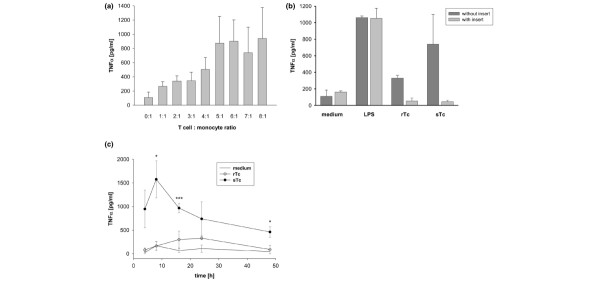
T cell induced production of TNF-α by monocytes from healthy donors. (a) Fixed stimulated T cells induce tumour necrosis factor (TNF)-α production by monocytes in a dose-dependent manner. Peripheral-blood T cells (106/ml) were cultured for 48 hours in the presence of immobilized anti-CD3 (3.3 μg/ml) and soluble anti-CD28 (0.8 μg/ml) antibodies. Stimulated T cells were fixed and incubated for 24 hours with freshly isolated monocytes (1.5 × 106/ml) at the indicated ratios. Values are means ± SEM from four different experiments. (b) Cell–cell contact is necessary for T cell-induced production of TNF-α in monocytes. Peripheral-blood T cells (106/ml) were cultured for 48 hours in the presence or absence of immobilized anti-CD3 (3.3 μg/ml) and soluble anti-CD28 (0.8 μg/ml) antibodies. Stimulated (sTc) and resting (rTc) T cells were fixed and incubated for 24 hours with freshly isolated monocytes (1.5 × 106/ml) at a ratio of 7:1 in a transwell system as described in the Materials and methods section. T cells and monocytes were physically separated by the semi-permeable membrane (with insert) or had direct cell–cell contact (without insert). Lipopolysaccharide (LPS; 100 ng/ml) was used as a positive control. Values are means ± SEM for experiments with three different donors. (c) T cell-induced TNF-α production by monocytes is time-dependent. Peripheral-blood T cells (106/ml) were cultured for 48 hours in the presence or absence of immobilized anti-CD3 (3.3 μg/ml) and soluble anti-CD28 (0.8 μg/ml) antibodies. Stimulated (sTc) and resting (rTc) T cells were fixed and incubated for the indicated durations with freshly isolated monocytes (1.5 × 106/ml) at a ratio of 7:1. Values are means ± SEM for experiments with three different donors. Levels of significance: * P < 0.05, *** P < 0.001.